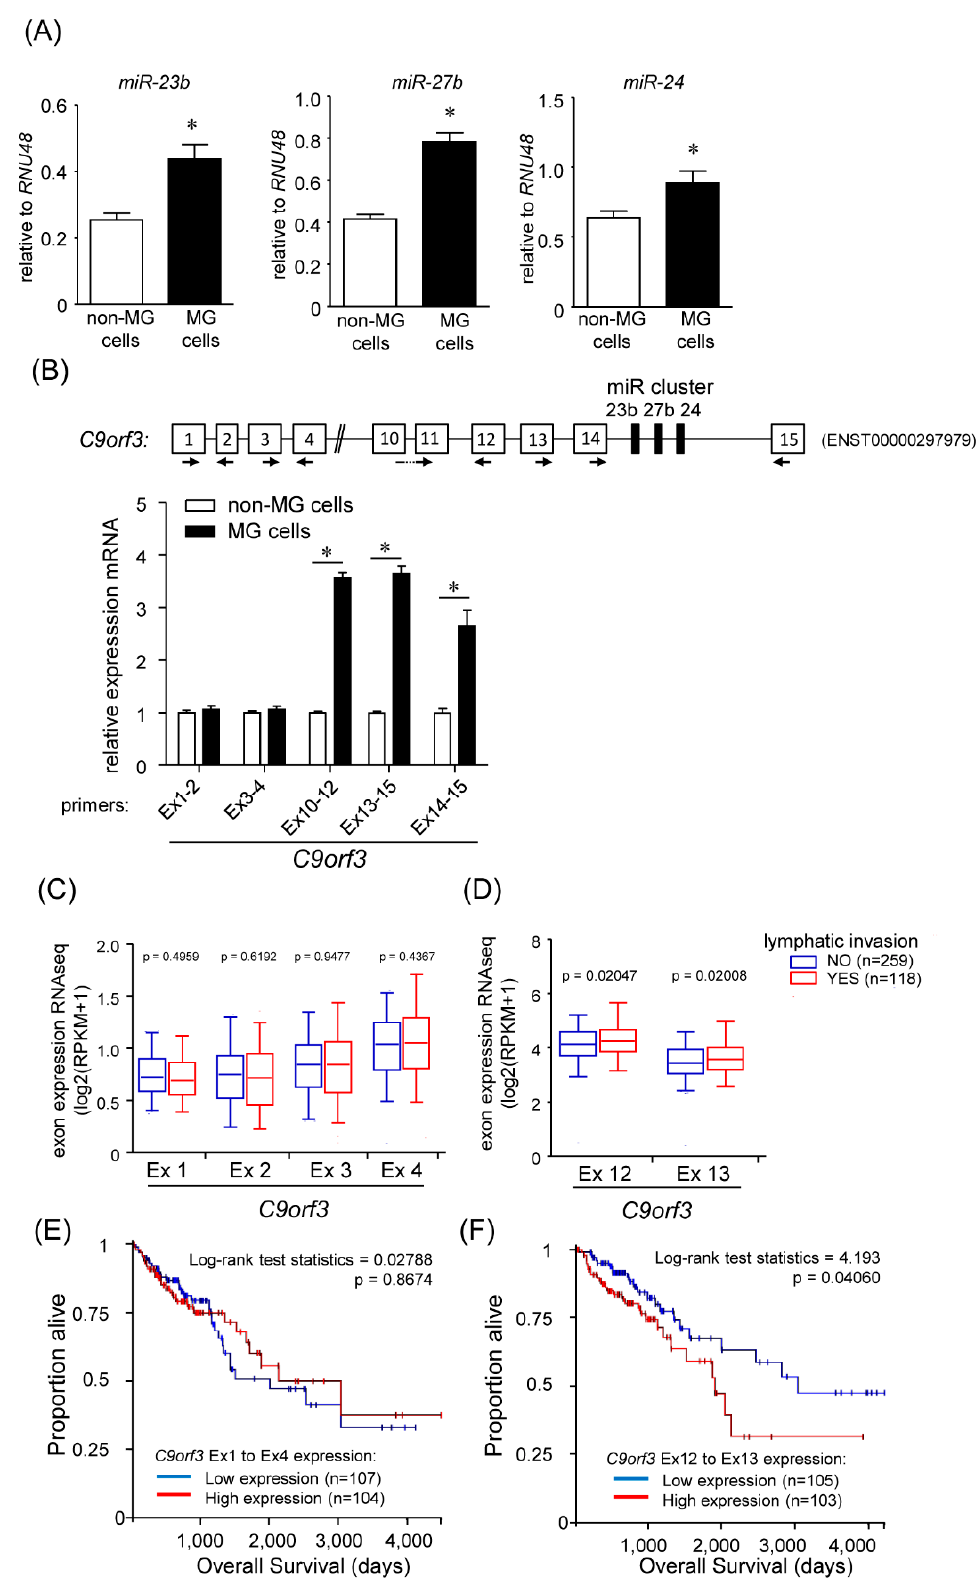
Figure 1. Up-regulation of the miR-23b/27b/24 cluster expression in migrated (MG) cells. ( A ) Relative expression levels of miR-23b , miR-27b, and miR-24 in non-MG cells and MG cells were measured by RT-qPCR. RNU48 was used as an endogenous control. ( B ) mRNA levels of C9orf3 , a host gene of miR-23b/27b/24 cluster, were measured by real-time reverse transcription polymerase chain reaction (RT-qPCR) using the indicated primer sets. Data are expressed as the mean fold changes ± standard